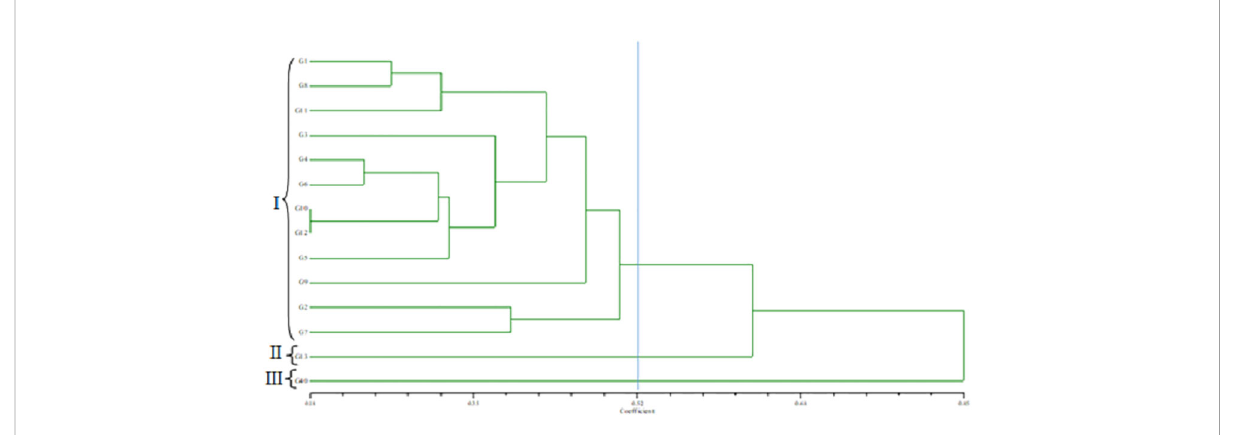
FIGURE 2 Dendrogram grouping the MR219-based population.